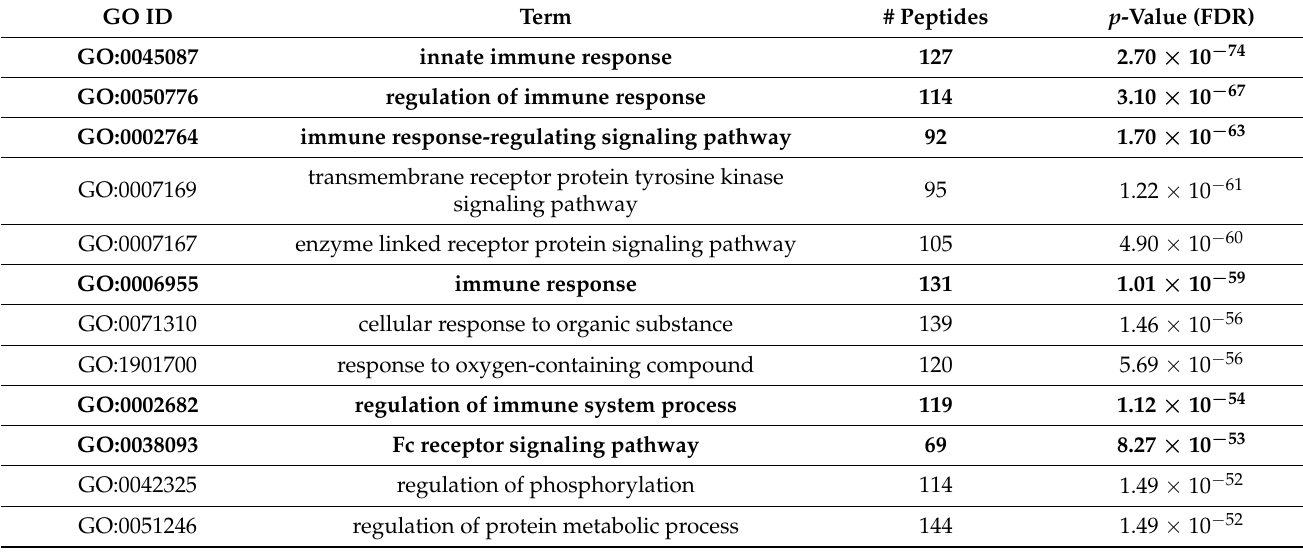
Table 12. The top 12 GO biological processes in sub-iliac lymph nodes collected from cattle that were experimentally and naturally infected with Salmonella. A list of representative GO terms was generated by taking the statistically significant peptides from the comparison and inputting this peptide list into the online STRING database. Presented below are the top 12 terms from the input data. The pathways in bold are those involved in the immune response (total immune peptides: